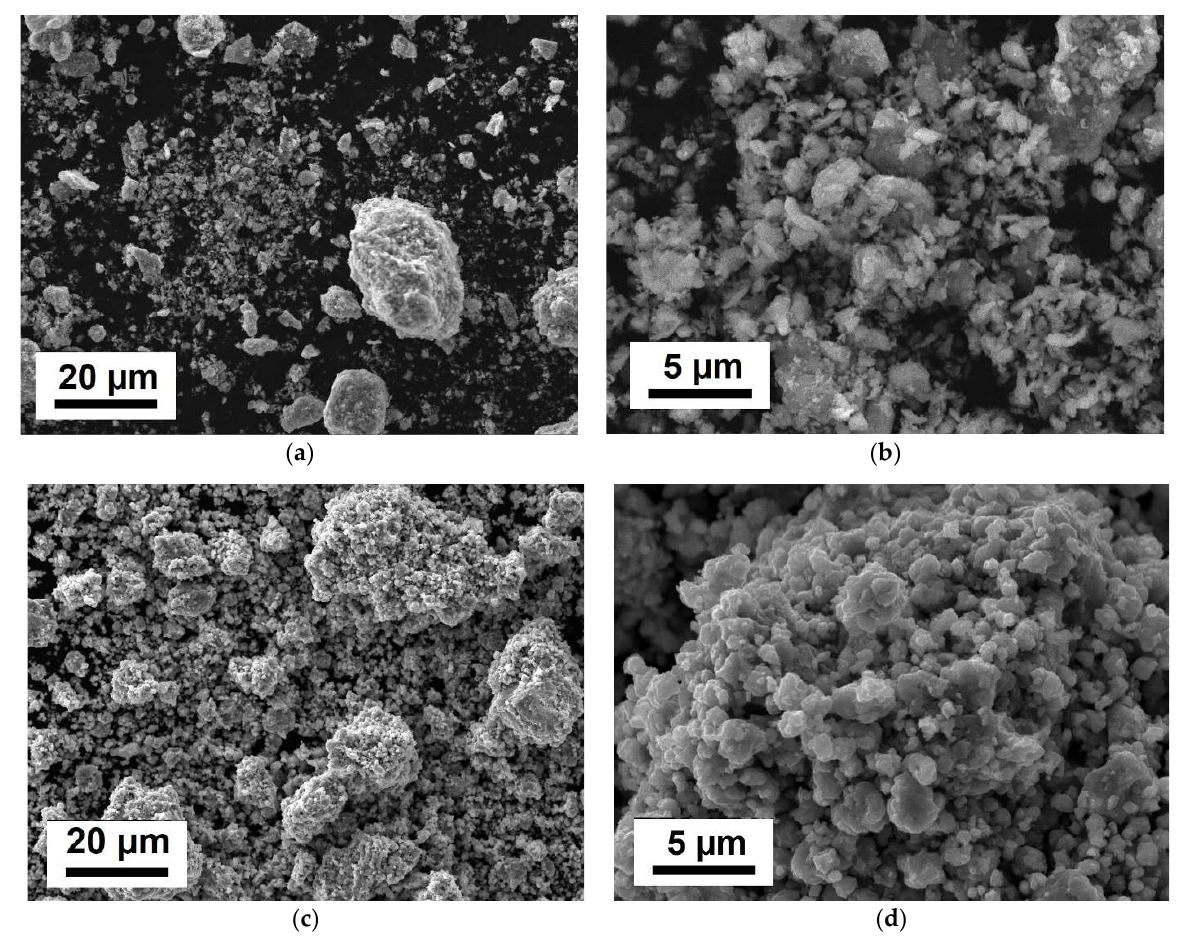
Figure 2. SEM images of the composite (chromium + 15% nanodiamonds) after 0.5 h ( a , b ) and 4 h ( c , d ) of treatment.